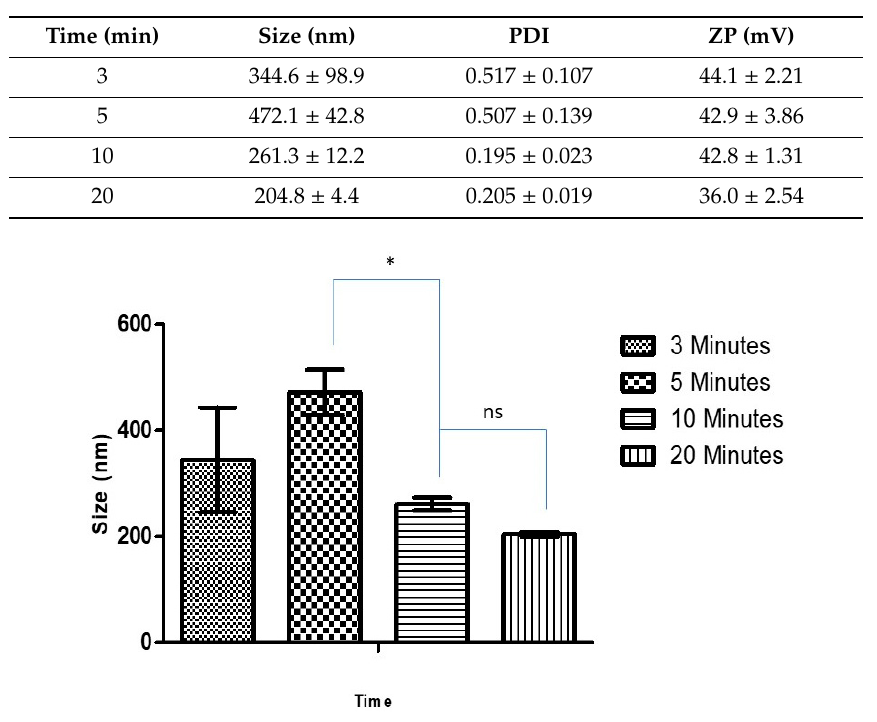
Figure 1. E ff ect of sonication time on size of blank CSNP; * significant di ff erence with CSNP size at Figure 1. Effect of sonication time on size of blank CSNP; *significant difference with CSNP size at 5 5 and 10 min sonication (p < 0.05); ns, and 10 min sonication (p < 0.05); ns, non-significant.